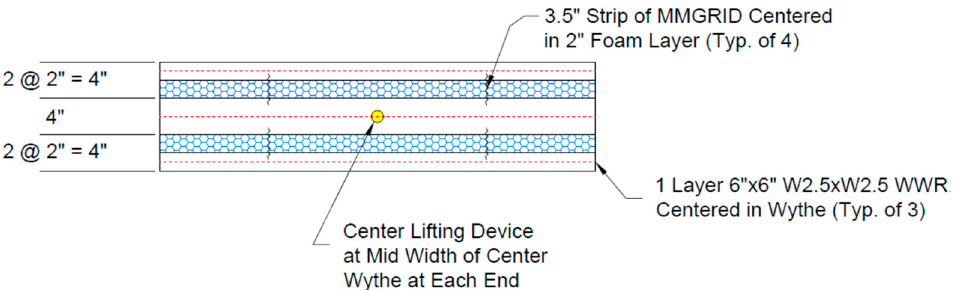
Figure 1. Cross-section of panel specimens with 2.0 in (51 mm) EPS insulation.